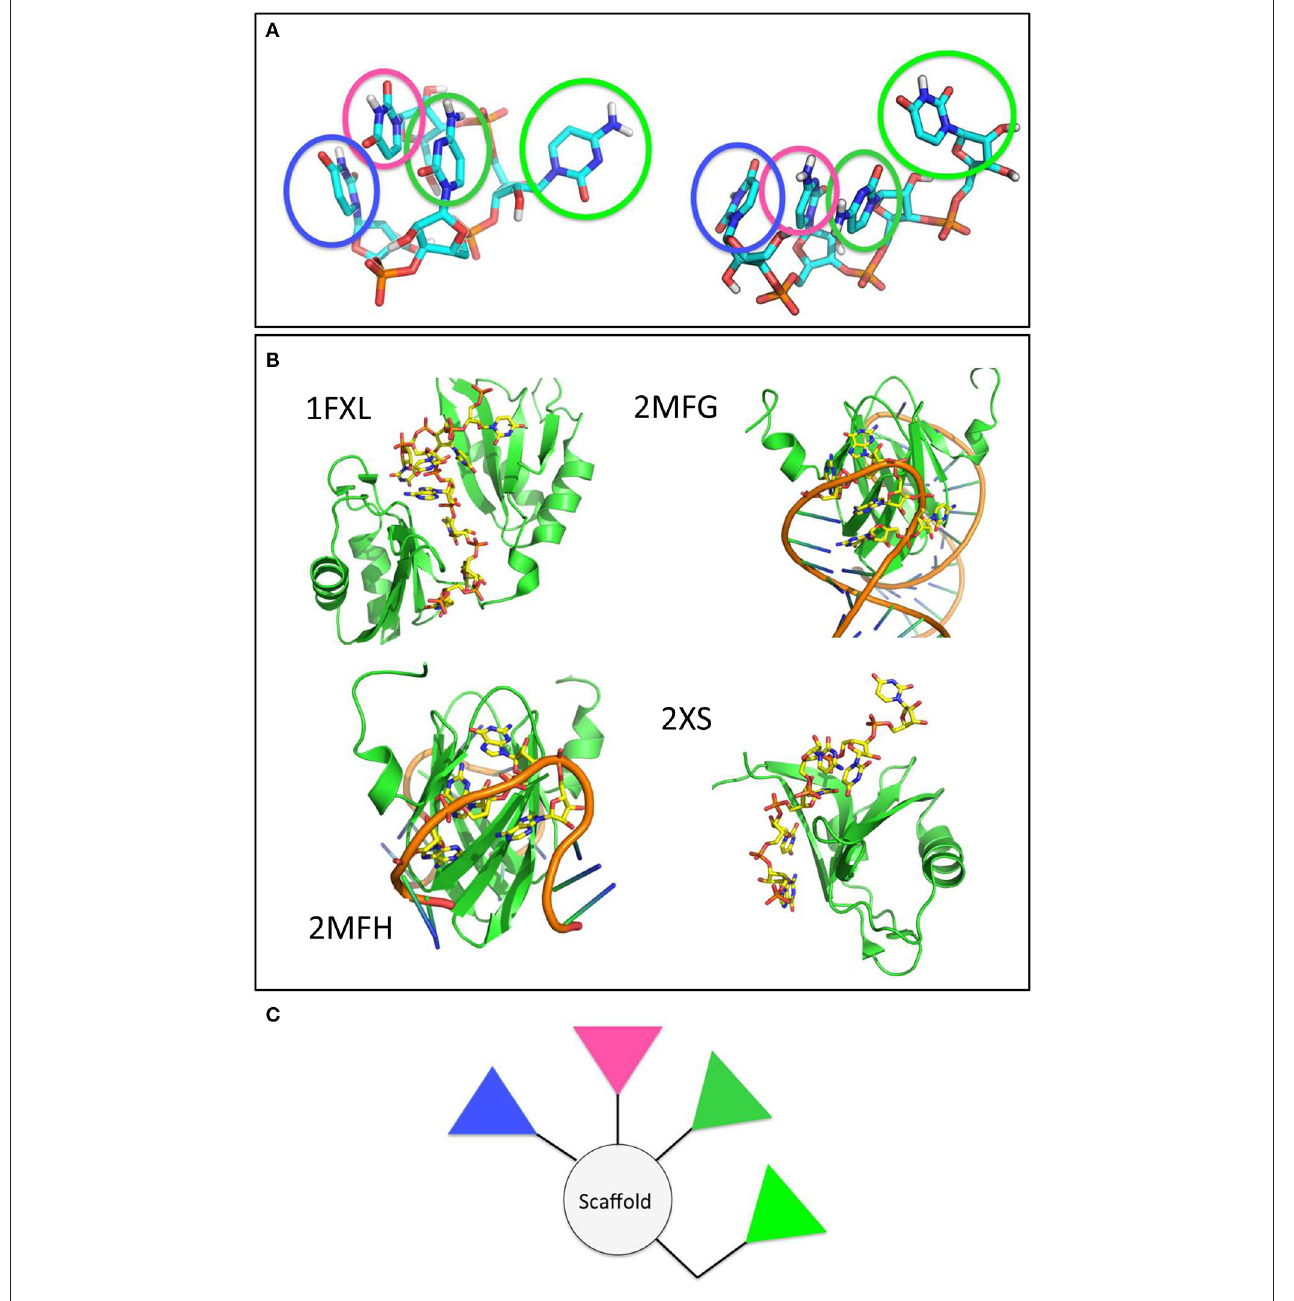
FIGURE 7 | The main clusters populated by the model RNA stretch in contact with the amyloid surfaces are found in RNA-protein complexes and shape potential pharmacophores. (A) Main conformational clusters of the interacting RNA. The pyrimidinic groups responsible for contact and binding are highlighted by transparent circles. (B) Experimental structures of RNA-protein complexes. The structures of the proteins and RNA stretches are shown in cartoon. RNA side chains in contact with the protein surface, forming structures reminiscent of those observed in the previous panel are shown as yellow sticks. (C) A proposed model pharmacophore, whereby the colors of the different triangles correspond to the colors of the circles highlighted in (A)